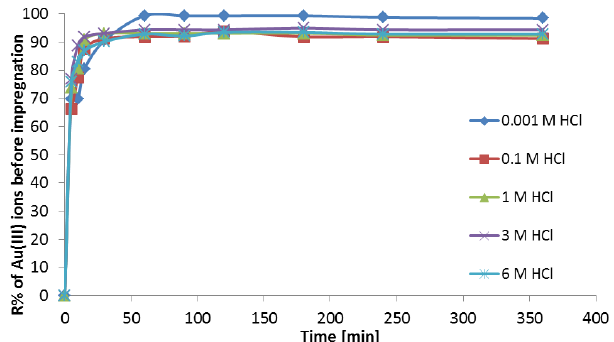
Figure 3. Influence of hydrochloric acid concentration and phase contact time on the removal of Au(III) ions (100 μg ·cm −3 ) from the aqueous solution using Purolite MN 202. The sorption of gold(III) ions on Purolite MN 202 is presented in Figure 3. Hydrochloric acid affects the gold(III) ion sorption. The value of R% is 99.3% in 0.001 M HCl. In the hydrochloric concentration range 0.1 – 6 M, the R% values are 91.25 – 94.37%. The re- covery percentages R% are higher in 0.001 M than in the range 0.1 – 6 M HCl for the